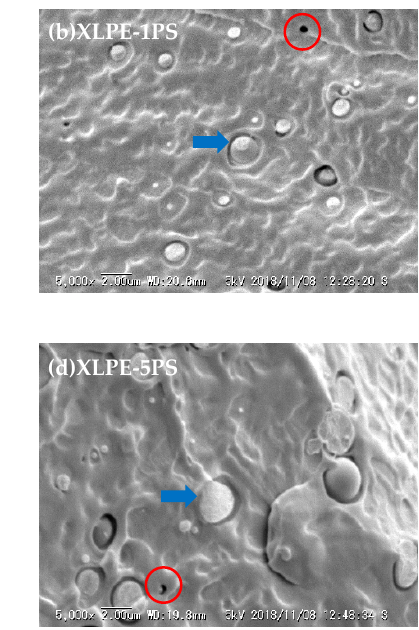
Figure 8. SEM micrographs of cryogenically fractured surfaces for samples. ( a ) XLPE; ( b ) XLPE-1PS; ( c ) XLPE-3PS; ( d ) XLPE-5PS. (Arrow: cross section, circle: cavity).